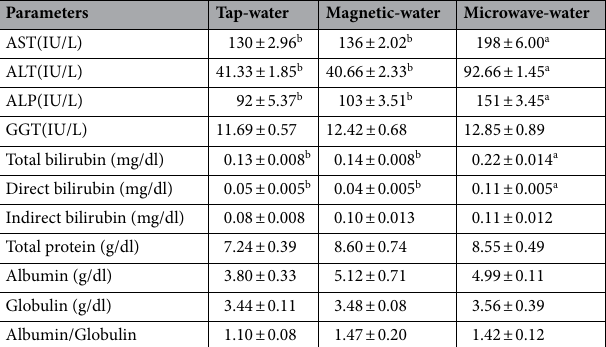
Table 1. Effect of water physical treatment on liver damage parameters in the rats (Mean ± SE). Values are presented as mean ± SE. Data with dissimilar letters [ a (the highest) and b (the lowest)] in the same row are significantly different at p ≤ 0.05. All groups were compared to each